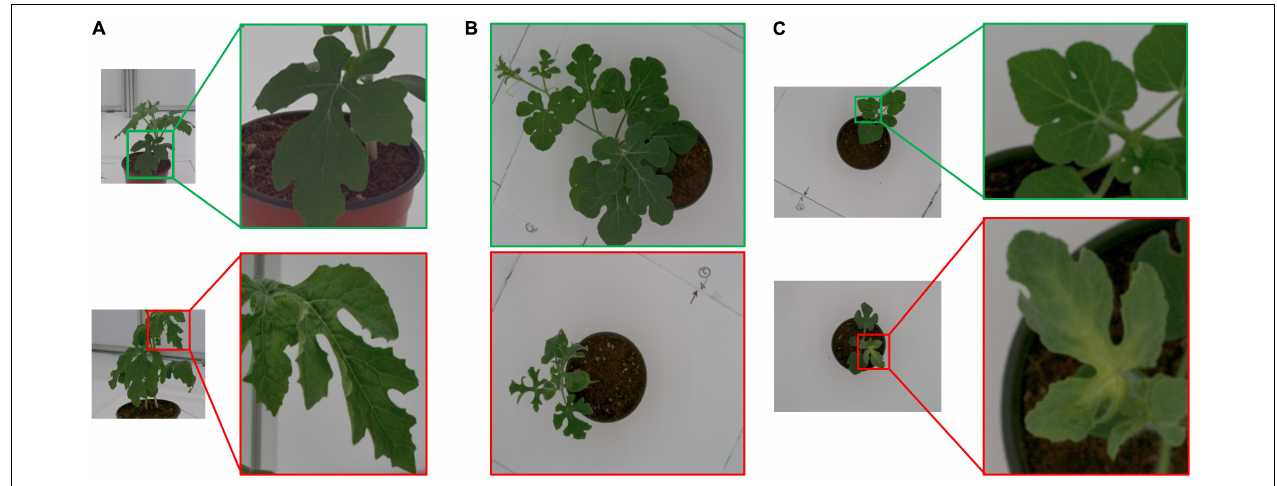
FIGURE 7 | (A) Textural difference between a normal (top) and stressed (bottom) plant at week 4. (B) Size difference between a normal (top) and stressed (bottom) plant at week 5. (C) Color difference between a normal (top) and stressed (bottom) plant at week 3.